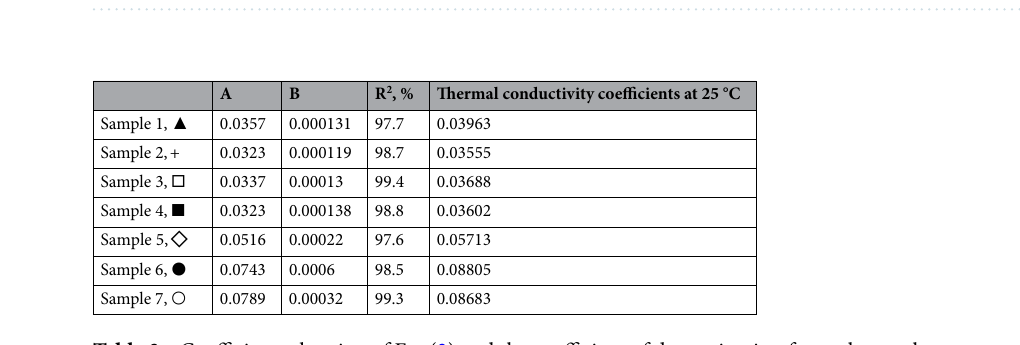
Figure 17. Thermal conductivity profiles at different temperatures for four various samples of loose facemasks (see Table 1 for more details).